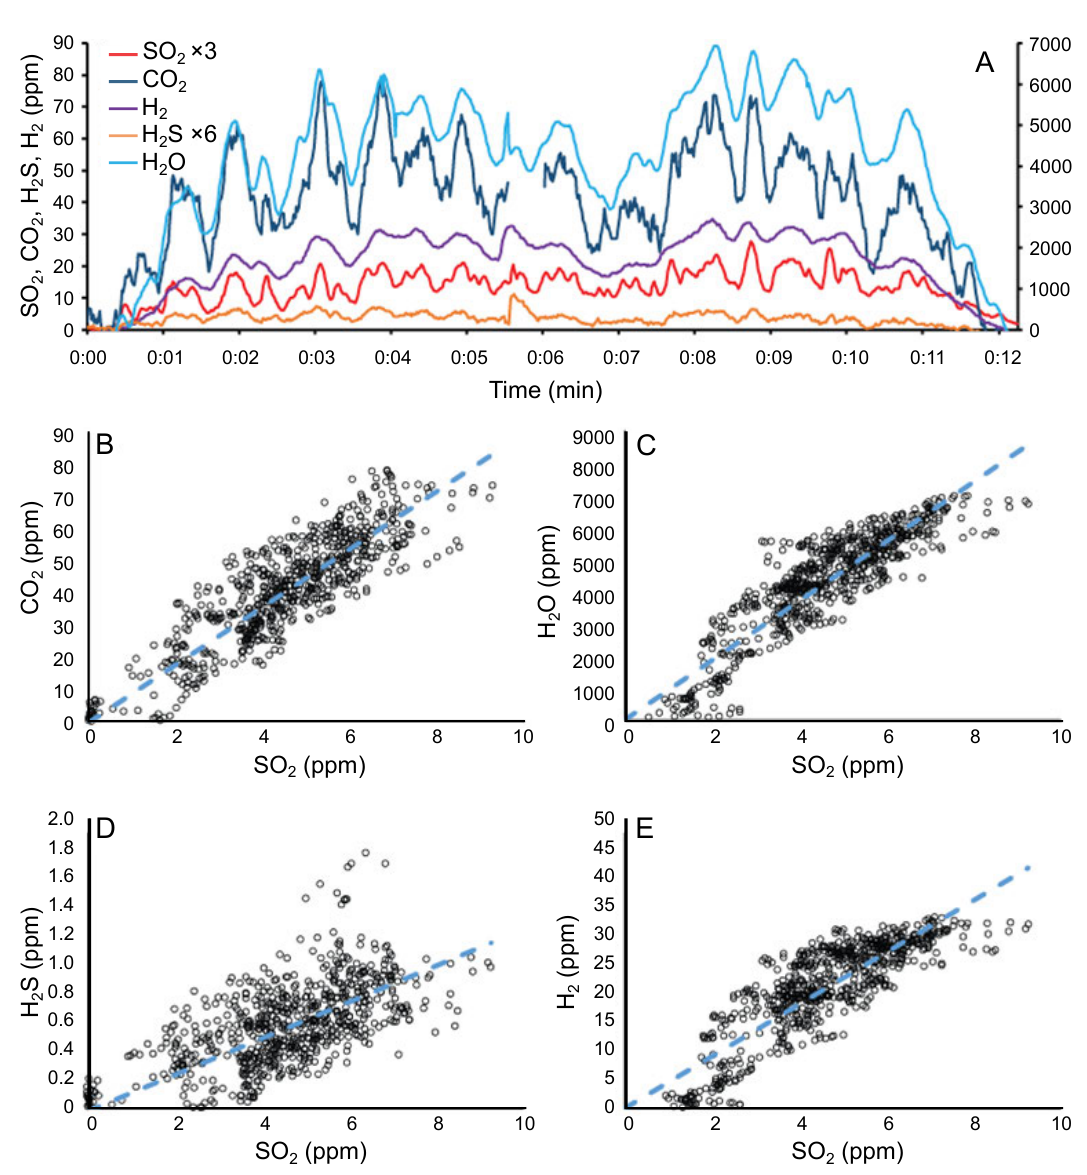
O is reported on 2 sensor is 2